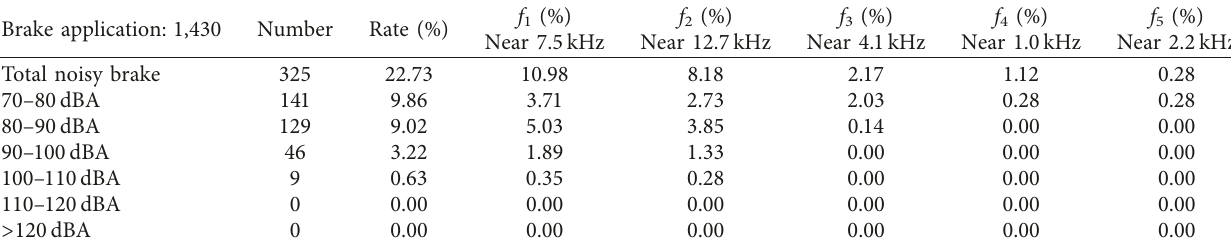
Figure 4: Noise frequency distribution and sound pressure level. Table 2: Noise occurrence rate at different frequency bands.